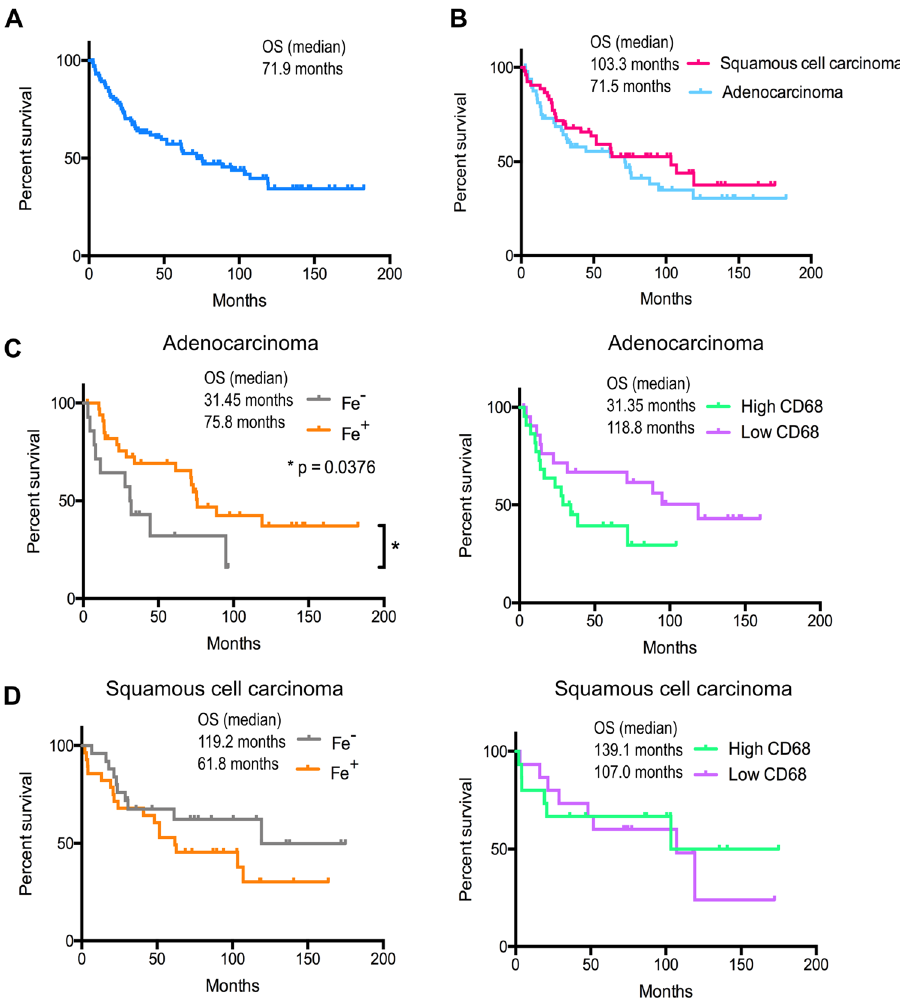
Figure 4. Adenocarcinoma patients positive for iron in the tumor microenvironment showed better overall survival. Kaplan Meyer survival analysis (Log-rank test) was performed for curve comparison of adenocarcinoma and squamous cell carcinoma. ( A ) Overall survival of all NSCLC patients (n = 102). ( B ) Overall survival according to histological subtype. ( C , left) Overall survival rates according to iron status in lung adenocarcinoma (n = 49). ( C , right) Overall survival rates according to TAM content of adenocarcinoma (n = 44). ( D , left) Overall survival rates according to iron status in lung squamous cell carcinoma (n = 53). ( D , right) Overall survival rates according to TAM content of squamous cell carcinoma (n = 30).